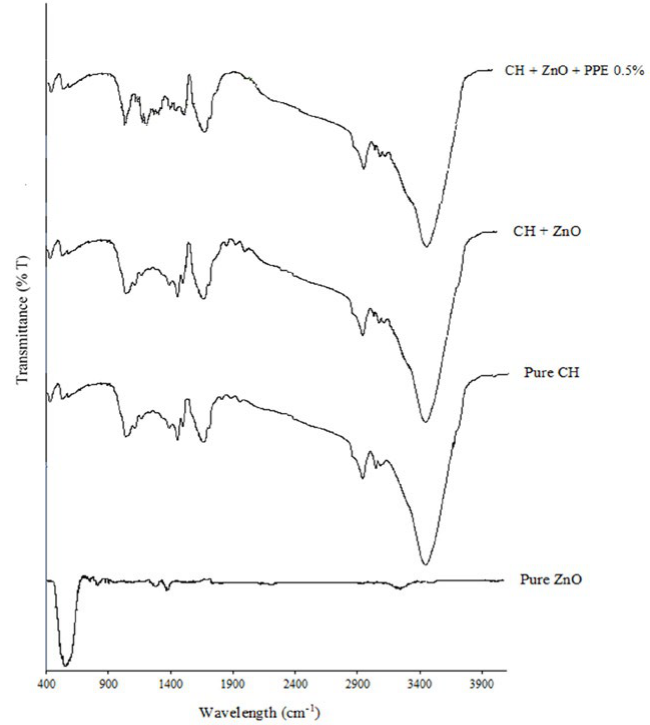
Fig. 3. FTIR spectra of ZnO, chitosan (CH), CH + ZnO and CH + ZnO + PPE 0.5%